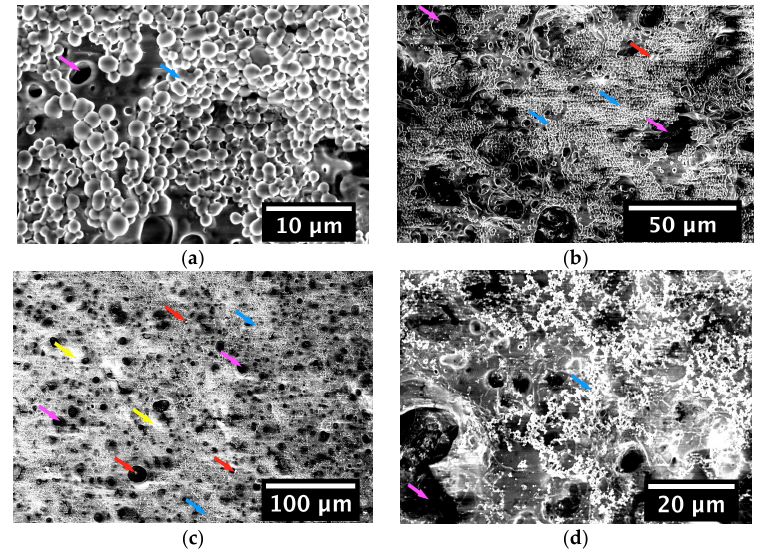
Figure 7. ESEM images showing the morphology of Cu ‐ doped 45S5 BG/zein coating surfaces produced by EPD and immersed in SBF for: ( a , b ) 1 day and ( c , d ) 14 days. BG particles (red arrow) are embedded in zein (blue arrow) which undergoes degradation (magenta arrow) visualized by holes that appear on the coating surface. Formation of hydroxyapatite (yellow arrow) is visible on some of the coatings.